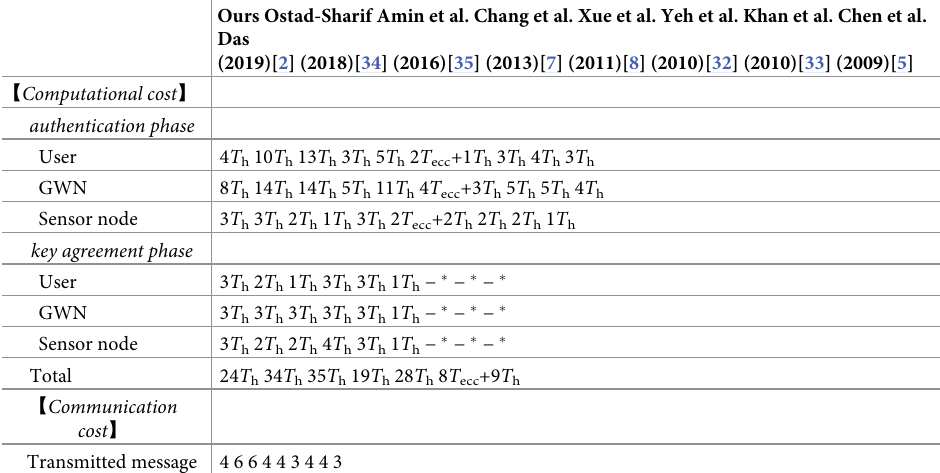
Table 4. Performance comparison of our scheme with other related